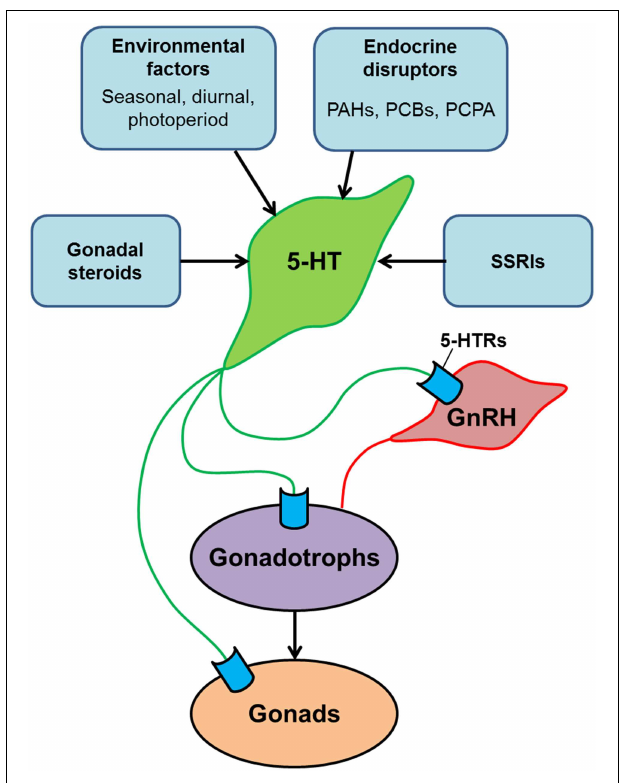
FIGURE 2 | Schematic model illustrating the serotonergic action on the hypothalamus-pituitary-gonadal axis of teleosts. Serotonin (5-HT) modulates the reproductive system at multiple levels: the hypothalamus (via GnRH neurons), the pituitary (via gonadotrophs) and the gonads. 5-HT system is modulated by several factors such as gonadal steroids, environmental factors and social cues. In addition, central 5-HT system is also influenced by chemical substances such as endocrine disrupters and selective serotonin reuptake inhibitors (SSRIs), which exist in surface waters and sewage effluents as contaminants. Exposure of fish to those chemical substances may have significant impacts on reproductive